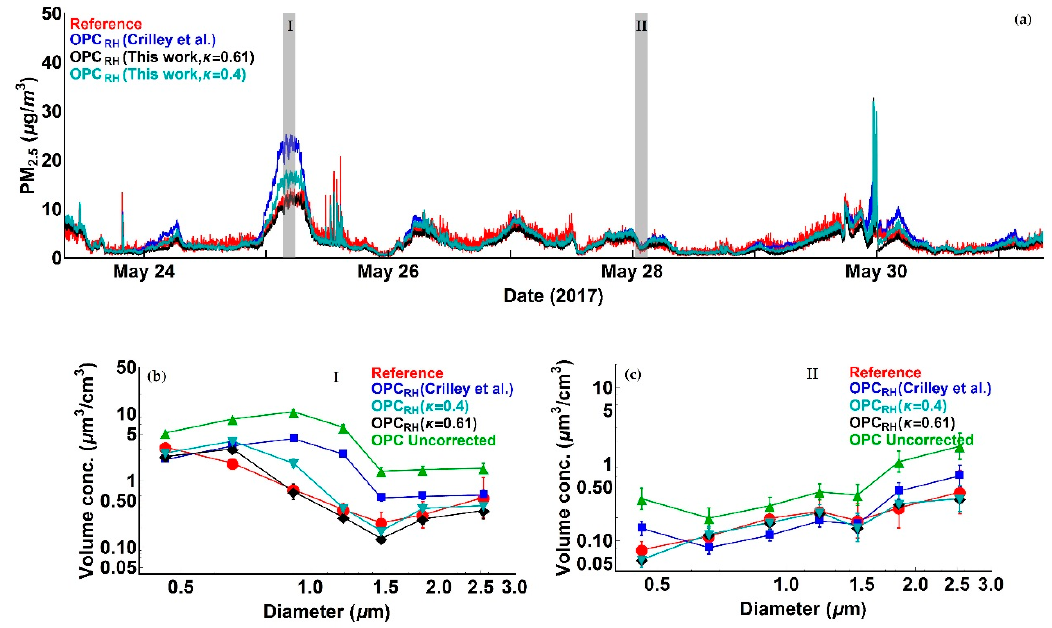
Figure 6. Figures illustrating Alphasense OPC-N2 measurements in comparison with reference data. ( a ) Time series of Alphasense OPC-N2 PM 2.5 measurements after the application of the correction factor [16] and the correction algorithm (this work) assuming a κ value of 0.4 (Cyan) and 0.61 (Black) in comparison with reference data; ( b ) Size distribution of Alphasense OPC-N2 volume concentration data for all size bins contributing to PM 2.5 before and after the application of the correction factor [16] and the correction algorithm (this work) assuming a κ value of 0.4 (Cyan) and 0.61 (Black) in comparison with reference data for period I (25 May 03:18:00 UTC–25 May 05:48:00 UTC); ( c ) as ( b ) except for period II (28 May 00:31:00 UTC–28 May 03:01:00 UTC).